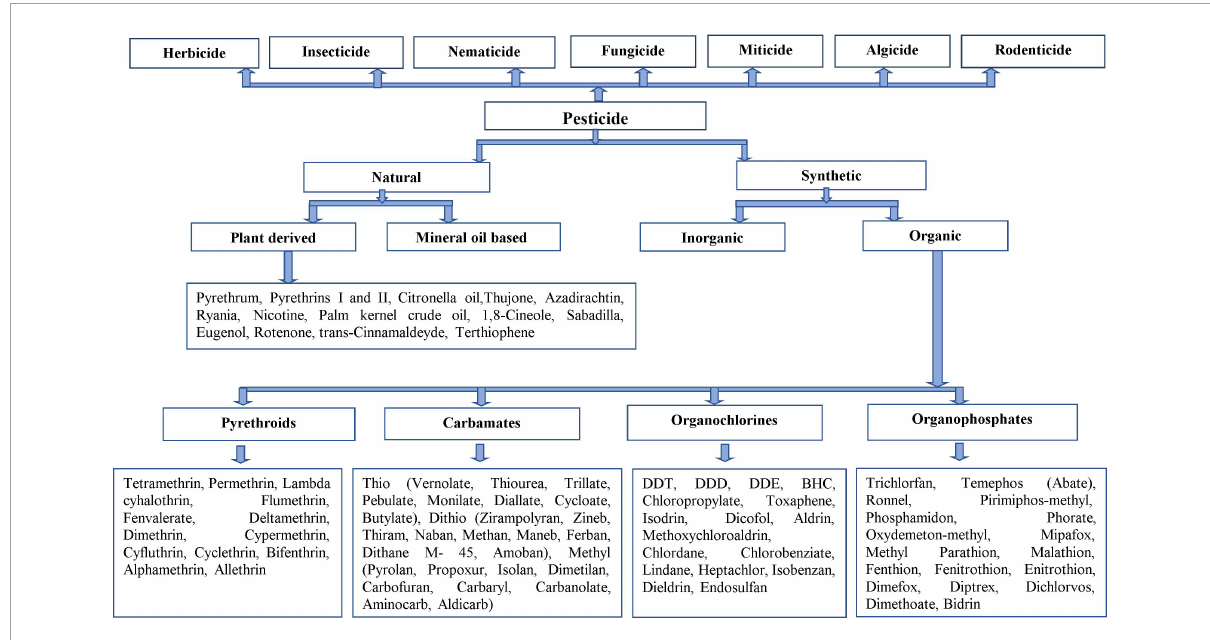
FIGURE3 Classification of pesticides (Jayaraj et al., 2016; Hassaan and El Nemr, 2020; Malhotra et al., 2021; Souto et al., 2021; Parra-Arroyo et al.,